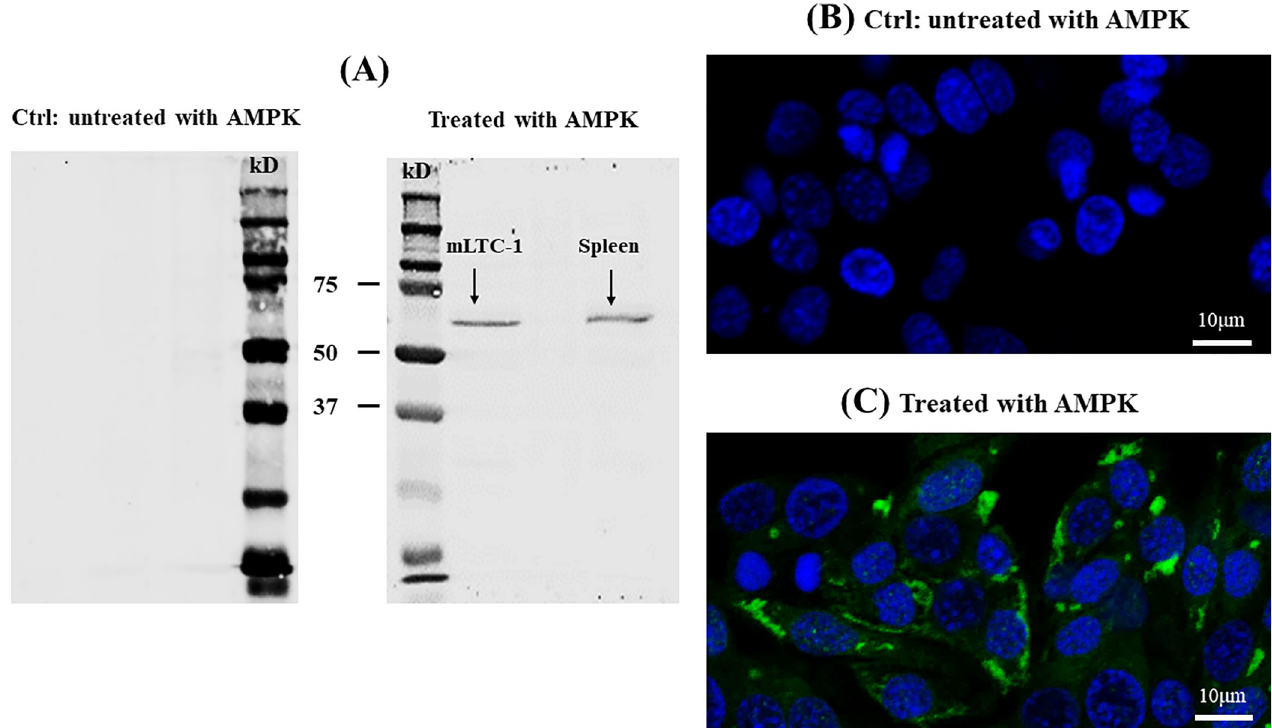
Fig 1. AMPK expression in MLTC-1 cells. (A) Identification of AMPK in MLTC-1. Cell lysates were resolved by SDS-PAGE, transferred to nitrocellulose membrane and then, probed with an anti-AMPK α antibody. Cell lysates from mouse spleen were used as positive controls (A: right). Negative control (Ctrl): primary antibody is missing (A: left). (B), (C) Immunolocalization of AMPK in MLTC-1 cells. Subcellular distribution of AMPK in Leydig cells was observed by confocal microscopy. AMPK α (C, green) immunoreactivity is detected in both the cell membrane and the cytoplasm. Nuclei were stained with DAPI (B, C, blue). Negative control (Ctrl): primary antibody is missing